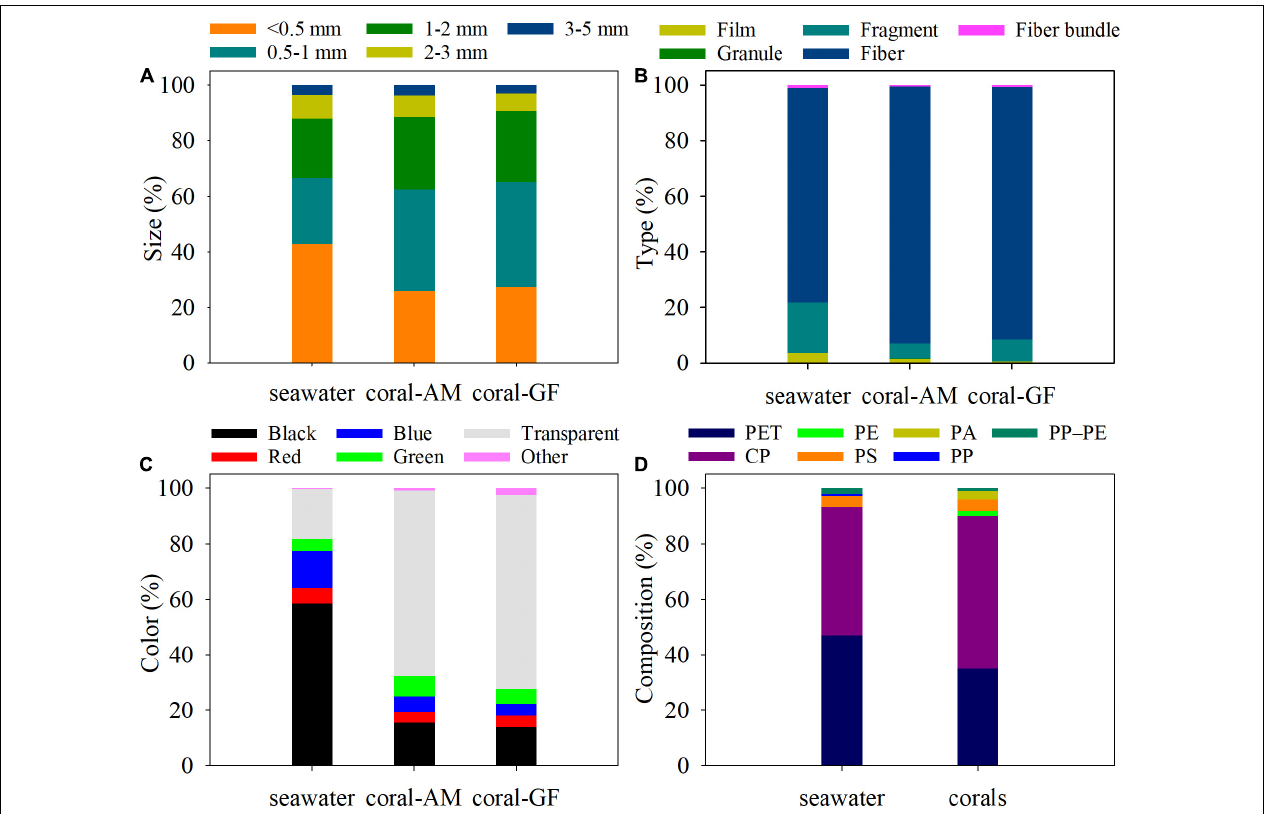
FIGURE 3 | Proportion of MPs size (A) , type (B) , color (C) and composition (D) in seawater and coral samples. AM, A. millepora ; GF, G. fascicularis .